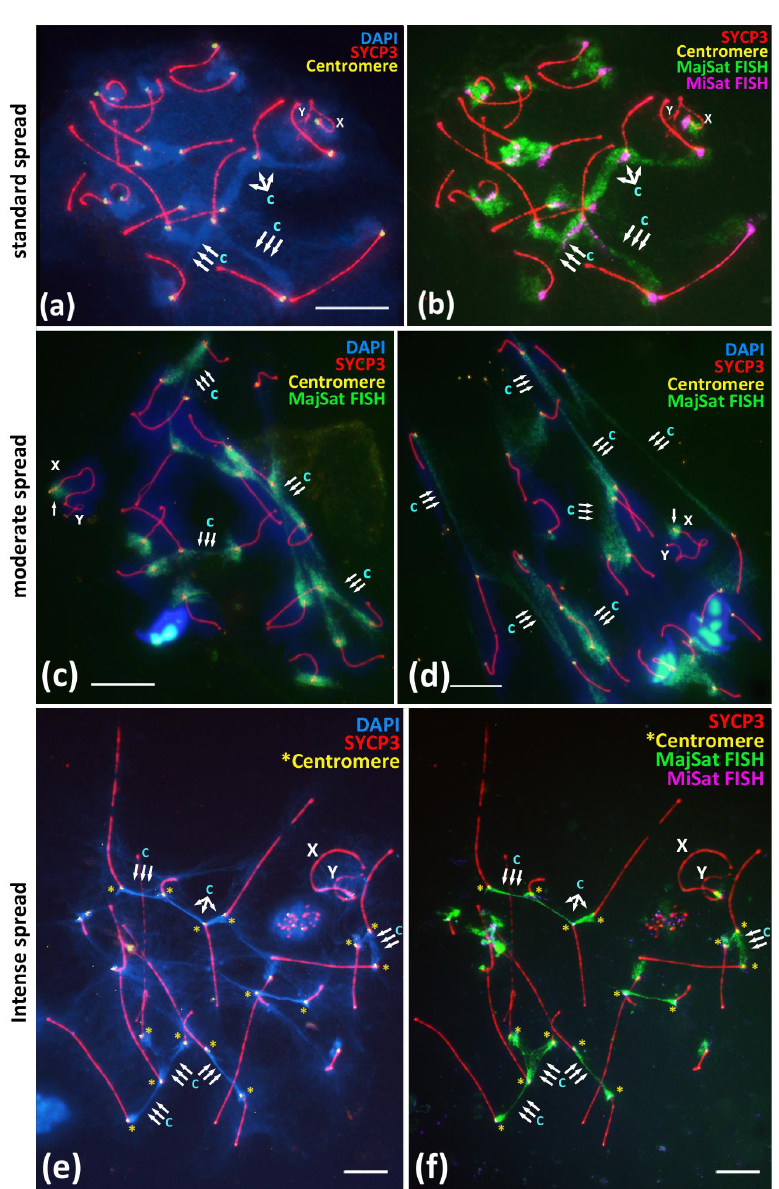
Figure 4. Immuno-FISH study of the Major and Minor satellite DNA localization in the pachytene F 4 nuclei spread preparations under different spreading conditions, BALB/c mouse. Chromatin was stained with DAPI (blue), FISH with oligo-DNA probes to MajSat DNA (green), and MiSat DNA (violet). Axial elements of meiotic chromosomes were immunostained with the antibodies against the SYCP3 protein (red), and centromeres were stained with the ACA antibodies (yellow). DAPI-enriched chromatin of chromocenters are indicated “c” and triple arrows. Sex chromosomes are indicated as “X” and “Y”. Scale bar—10 µ m. ( a , b )—Immuno-FISH on meiotic prophase I nuclei, pachytene, normal spread. Interbivalent chromocenters demonstrate predominant coverage by MajSat DNA (green) and smaller elongated signals of MiSat DNA (violet). ( c , d )—Immuno-FISH on meiotic prophase I nuclei, pachytene, moderate spread. Chromocenters manifest as stretched chromatin fibers enriched in MajSat DNA. Sex bivalent form spatially separated structure and not connected with autosomal bivalents, the MajSat region of X chromosome is not stretched. ( e,f )—Immuno-FISH, pachytene, intense spread. Tight linkage of centromeres by interbivalent stretched chromatin fibers. (e) —Chromatin of chromocenters is DAPI-enriched and indicated as “c”. ( f )—The same cell after FISH. Chromocenter chromatin fibers (green) binding the centromeric ends (yellow asterisks) of different autosomal bivalents are enriched in MajSat